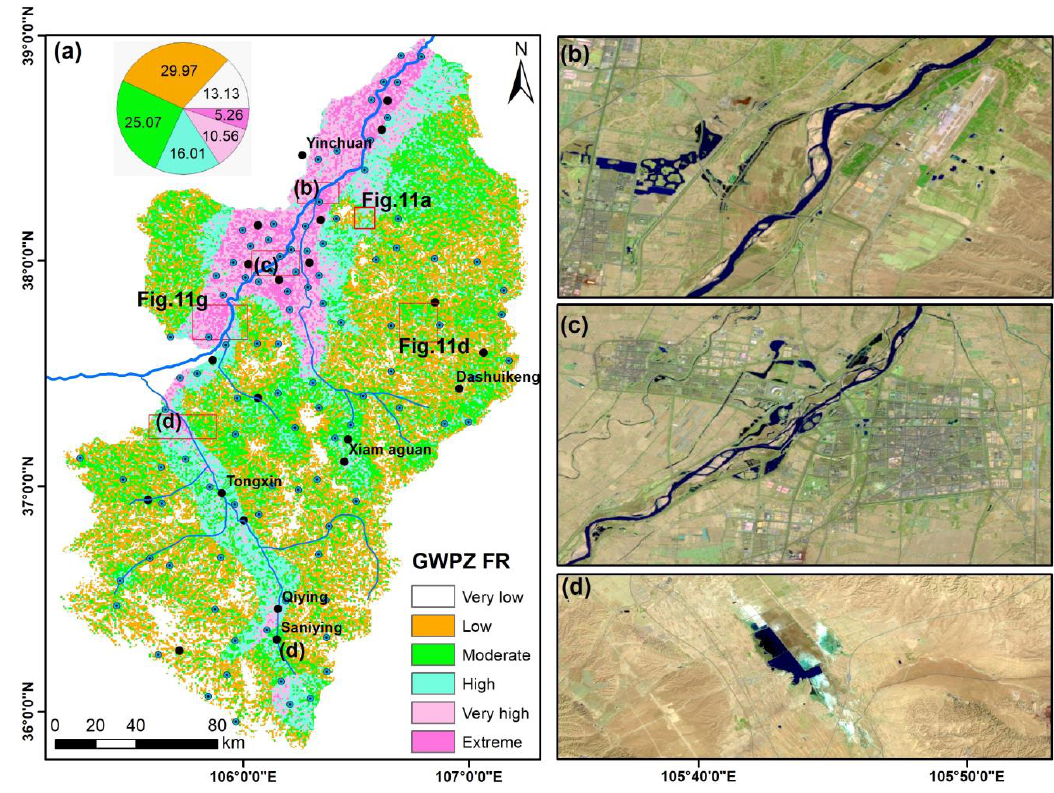
Figure 8. A two-dimensional bar chart, for comparing the FR values among classes of the influencing factors (e.g., soil, elevation, aspect, TRI, depressions, lineaments, distance to rivers, rainfall, and drainage density (Dd)) and the areas covering the GWPZs.